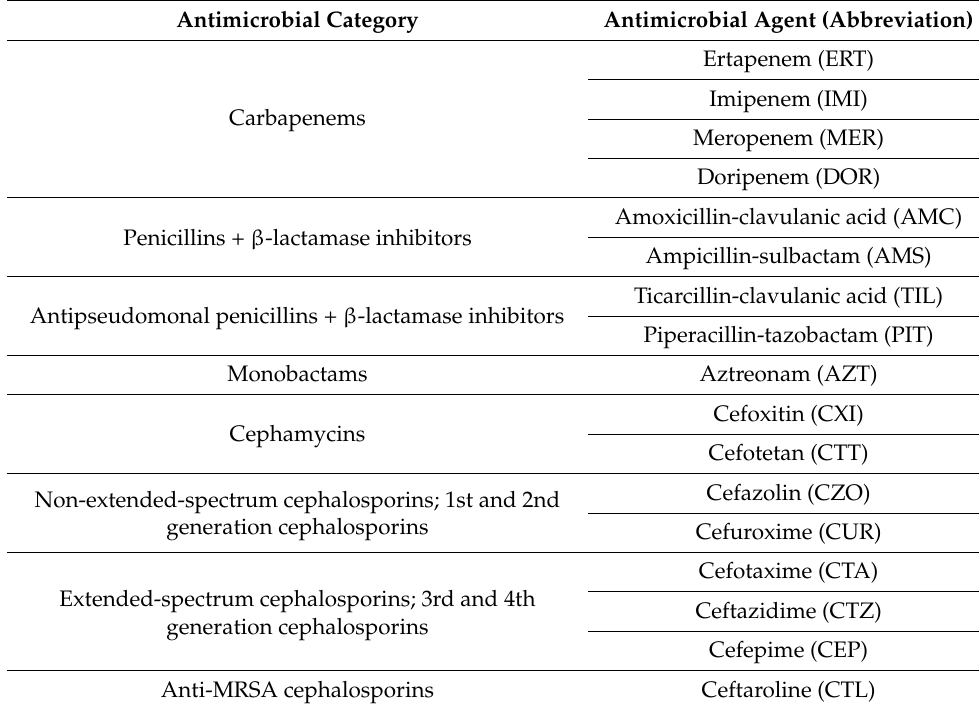
Table 1. β -lactam antimicrobial categories and agents considered for this study according to the ECDC/CDC